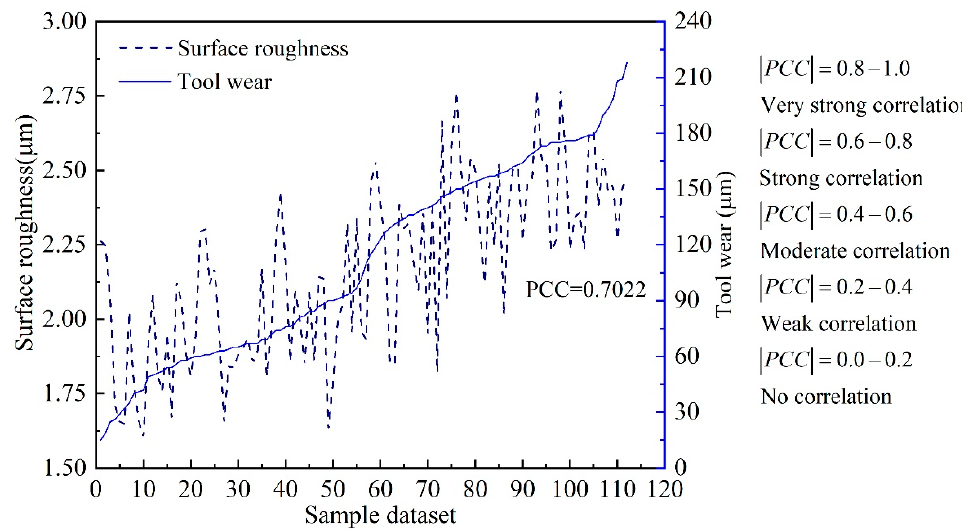
Figure 11. The correlation analysis of surface roughness and tool wear.